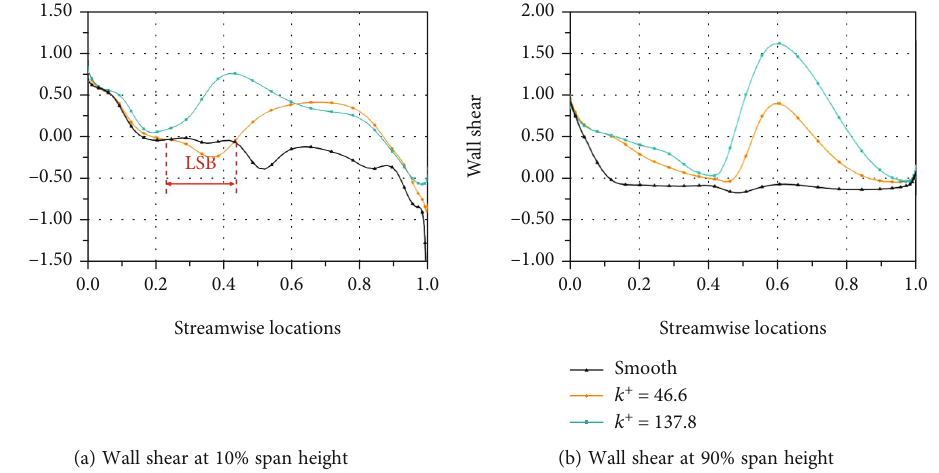
Figure 12: Skin normalized wall shear of the suction side at k + = 46 : 6 and 137.8.